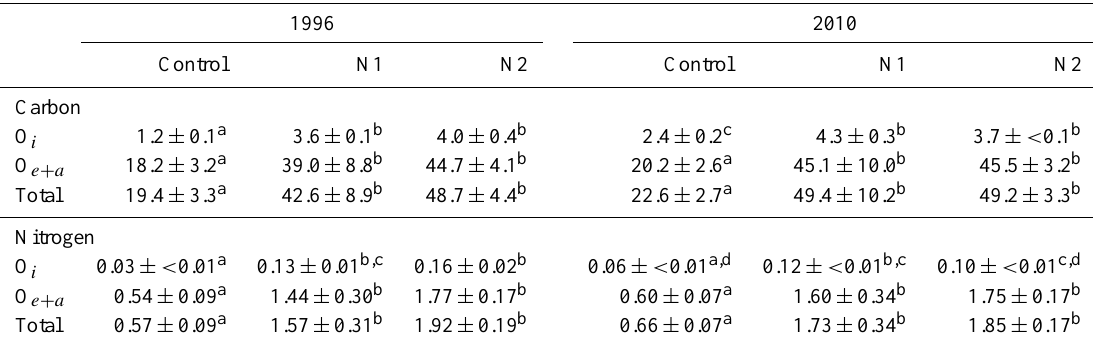
Table 2. Soil carbon and nitrogen pools in 1996 and 2010 (tonnes C and Nha − 1 , respectively). Values are mean ± range ( n = 2). Superscripts ( a , b , c and d ) denote significant differences at P = 0 . 05 (Tukey HSD test). Within rows, means lacking a common superscript differ. Data from 1996 are from Andersson et al.